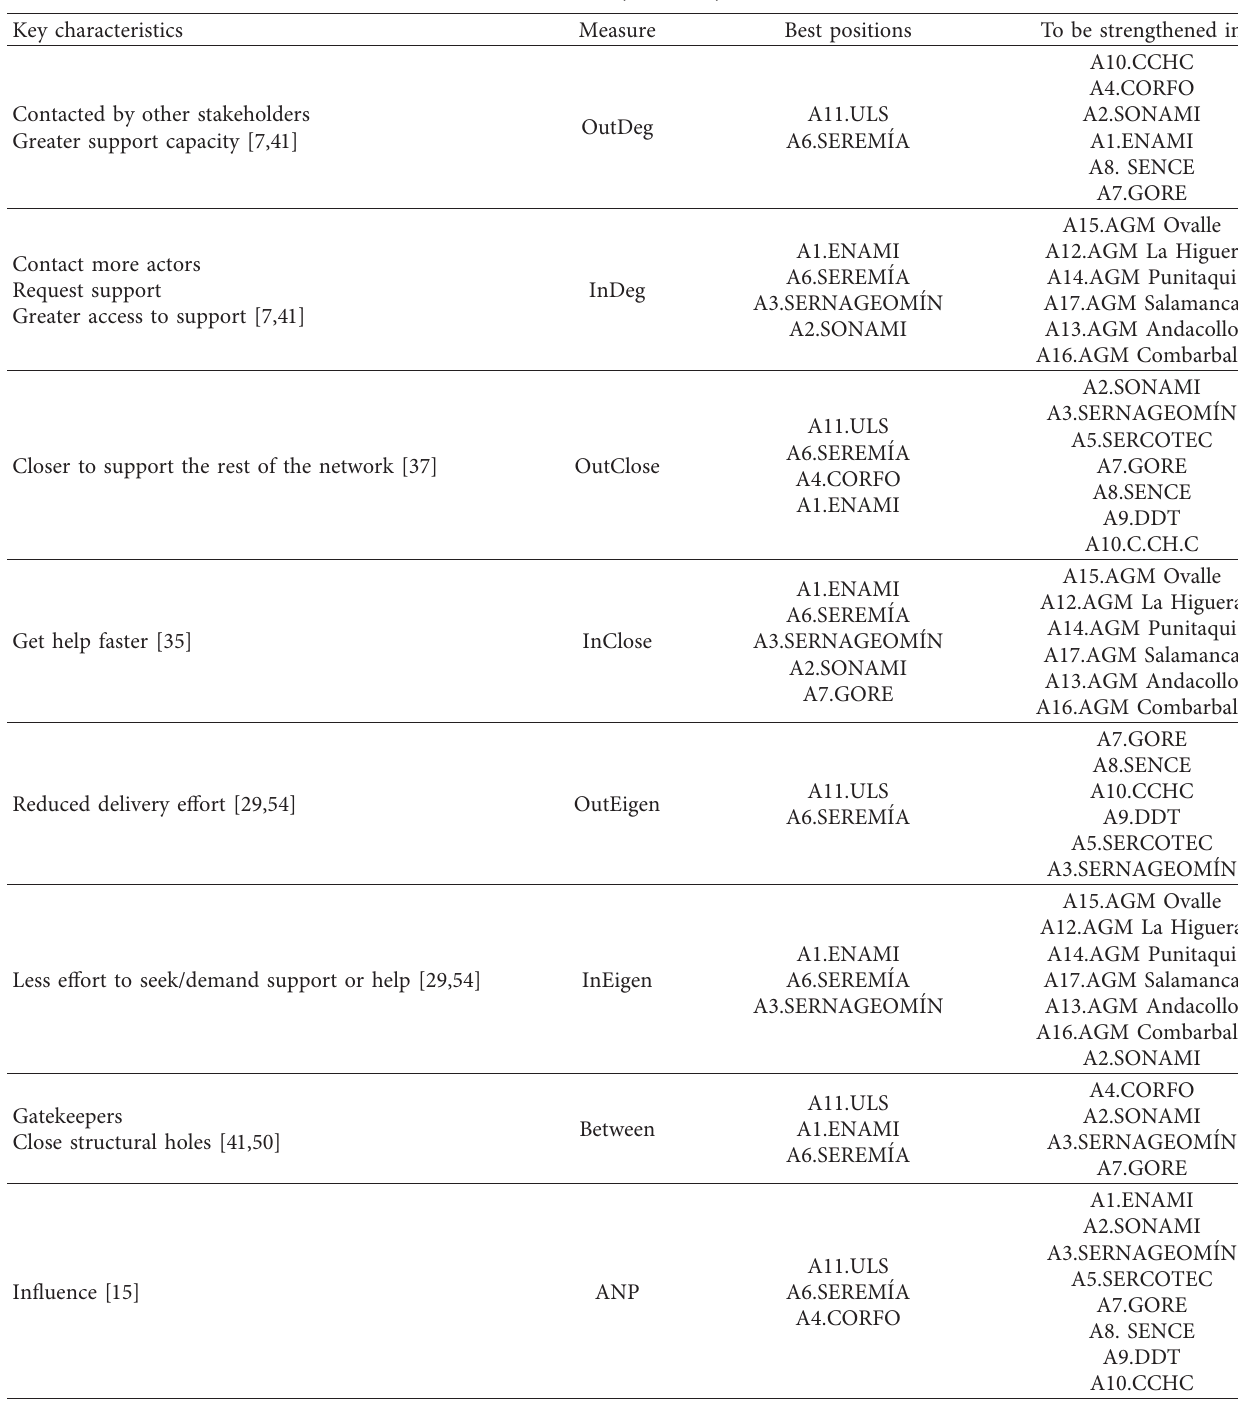
Table 9: SNA-ANP analysis vs. key